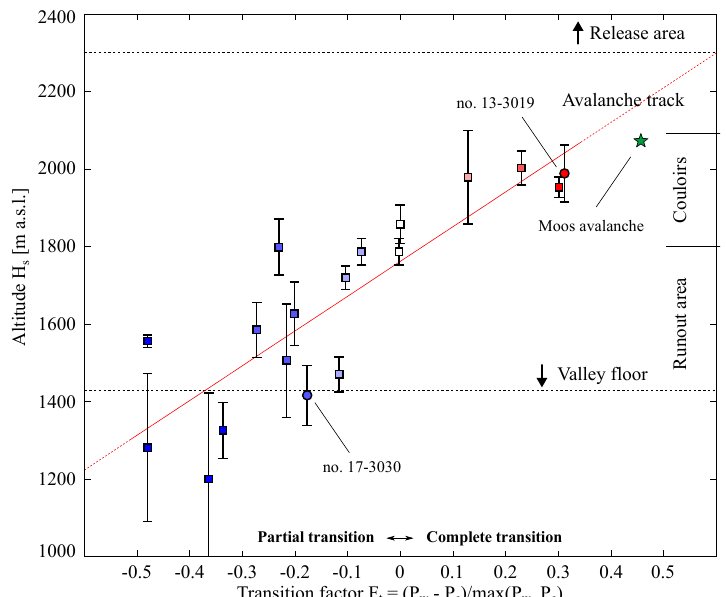
Figure 5. Transition index F t as a function of H s with a linear regression in red. The transition index F t has an uncertainty of ± 0 . 05 to 0.1.The green star belongs to the Moos avalanche mentioned in the introduction. Horizontal dashed lines and annotations on the right side roughly characterize the VdlS